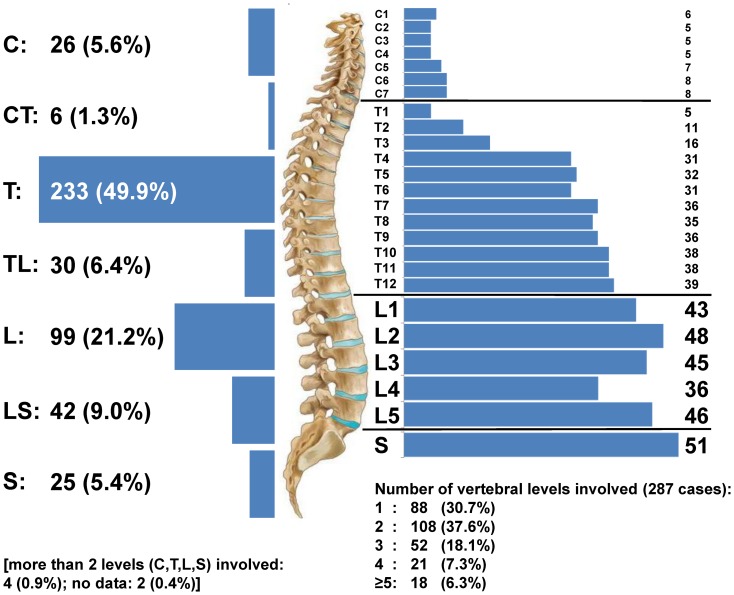
Anatomical allocation of spinal CE.Left: frequency of involved spine levels in 467 cases [C: cervical; CT: cervico-thoracal; T:
thoracal; TL: thoraco-lumbal; L: lumbar; LS: lumbo-sacral; S: sacral]. Right: top: frequency of
the involved vertebral levels in 303 cases. bottom: number of vertebral levels involved in 287
cases.